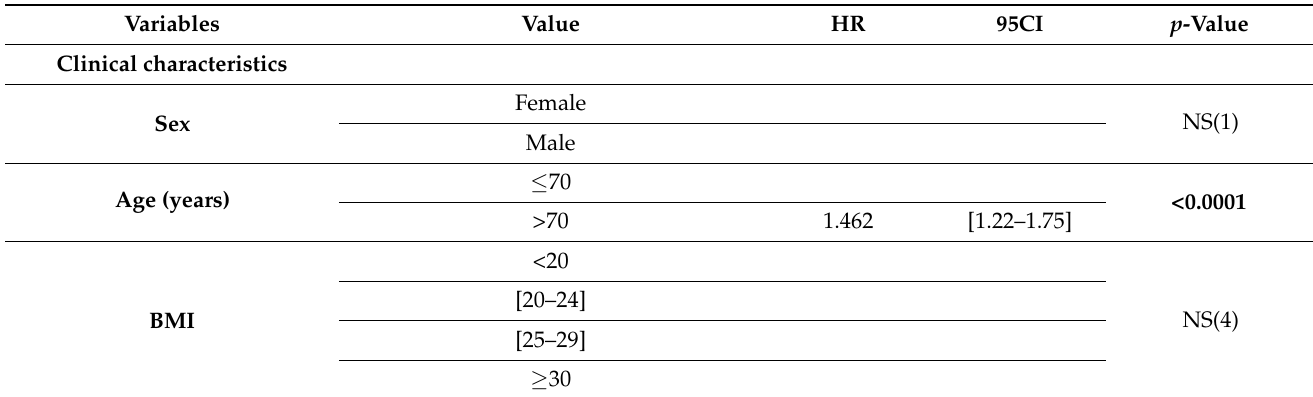
Table 2. Impact of clinical features and socio-spatial determinants on the overall survival in the global cohort after multivariate analyses. The final model included 530 patients. The number presented between parentheses in the p -value column corresponds to the rank of the variable in the multivariate analysis based on its p -value. p -values < 0.05 are marked in